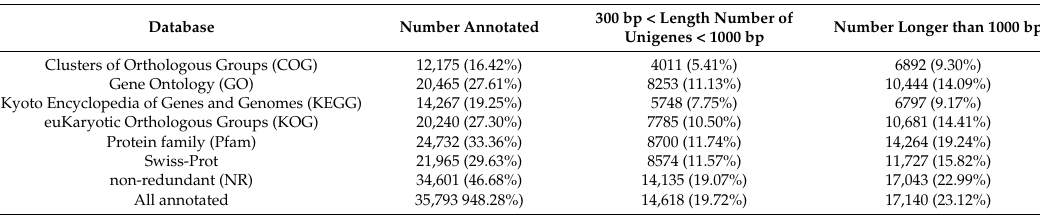
Table 3. Summary statistics of functional annotations for Polygonatum sibiricum unigenes via public